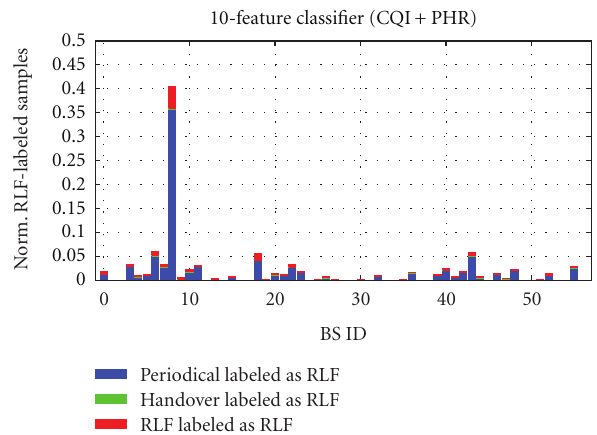
Figure 7: RLF-labeled samples per base station in problem